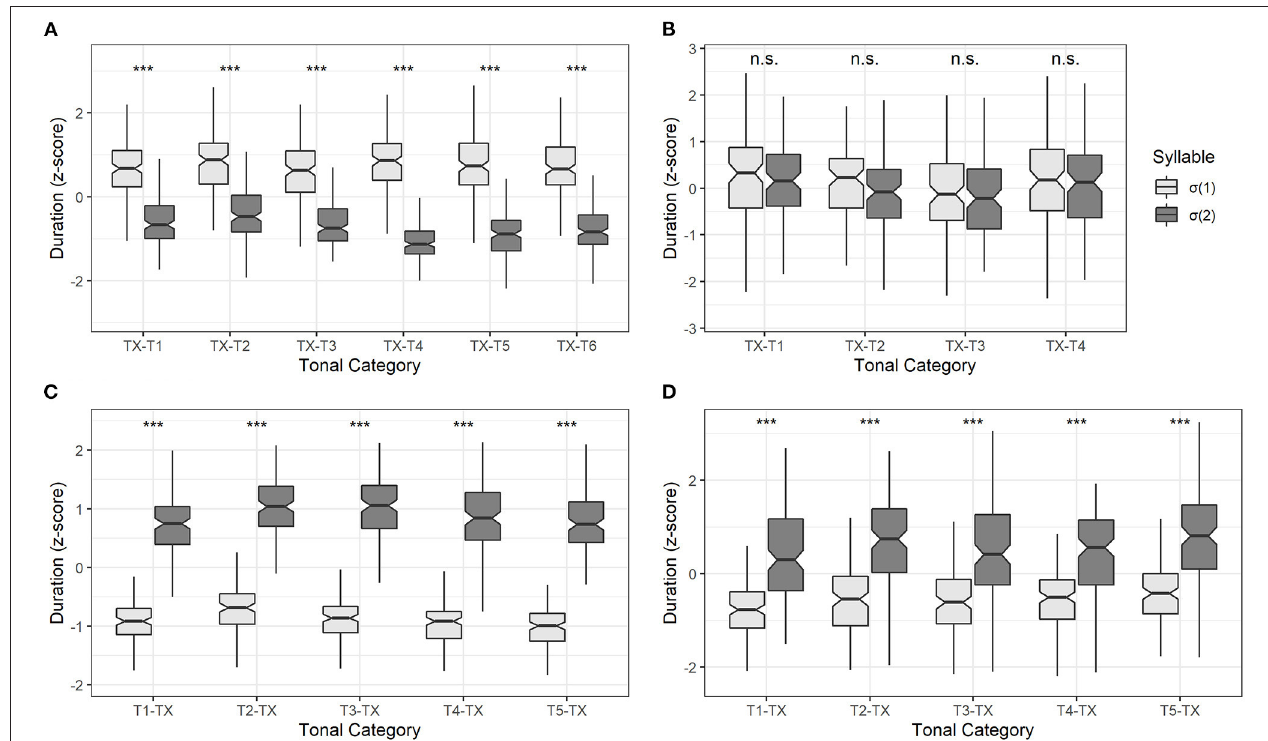
FIGURE 3 | The normalized duration of σ (1) and σ (2) with different tonal categories in Changsha (A) , Chengdu (B) , Fuzhou (C) , and Xiamen dialect (D) . Asterisks (***) stand for p < 0.001. The “n.s.” stands for a p -value higher than 0.05.